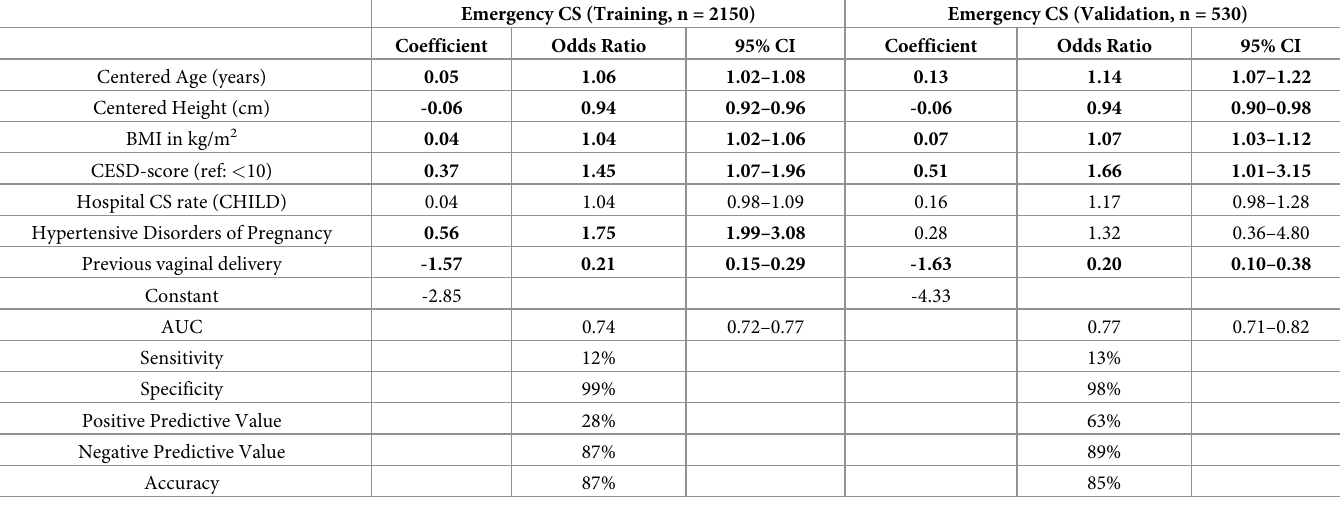
Table 2. Multiple logistic regression results include demographic, antenatal physical and obstetric characteristics in overall cohort independent of the parity: (Training and validation